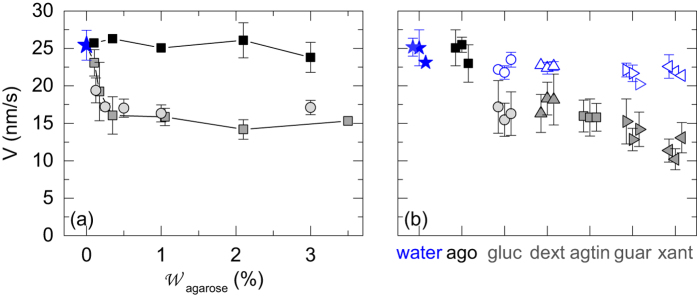
(a) Average thinning rate V determined at the center of the Petri dish for agarose gels (■), agar gels composed at 70% of agarose  and agarose gels loaded with 0.43% w/w of glucose , vs the concentration in agarose. The amount of saccharides (0.43% w/w) is chosen so that the ratio agarose/saccharide for all the samples is identical to the ratio agarose/agaropectin in the agar sample, which is 7:3. The blue star  denotes the thinning rate of a water pool with the same volume as the agar(ose) gels and monitored in the exact same experimental condition (temperature 25 °C, and dish diameter 50 mm). Error bars correspond to average standard deviation associated with three independent measurements performed over 10 minutes each. Experiments conducted in a plastic Petri dish made of PS. (b) Average thinning rate V of a 1% w/w agarose gel (“ago”) and four different 1% w/w agarose gels loaded with 0.43% w/w of one of the following non-gelling saccharides: glucose (“gluc”, ), dextran (“dext”, ), agaropectin (“agtin”, ), guar gum (“guar”, ) or xanthan gum (“xant”, ). Note that the data for the gel loaded with agaropectin were measured directly on an agar gel - we did not mixed agaropectin and agarose. Finally, the blue open symbols (◦, ▵, ▹, ◃) stand for measurements performed on the aqueous solution of the corresponding saccharide, at the same concentration and without any agarose. Data are missing for an aqueous solution of agaropectin, which is not commercially available as a pure product. For each additive three independent experiments are performed on gels prepared anew. Error bars correspond to the standard deviation of the average thinning rate over the duration of the experiment (10 minutes). Experiments conducted at T = (25.0 ± 0.5) °C in a plastic Petri dish made of PS.